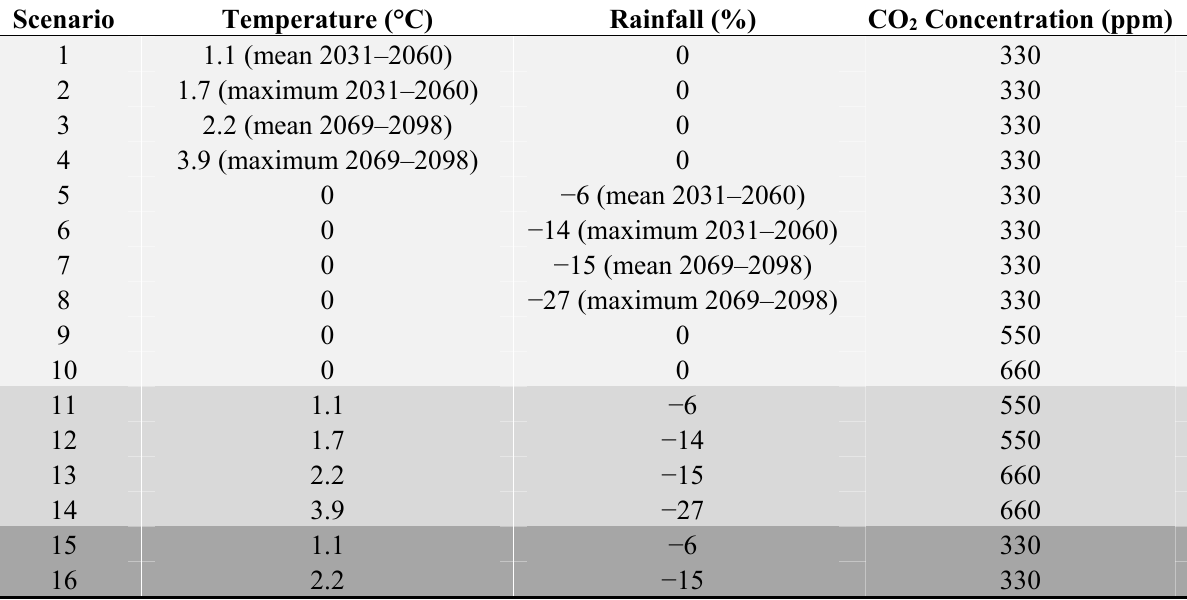
Table 3. Climate change scenarios used for SWAT